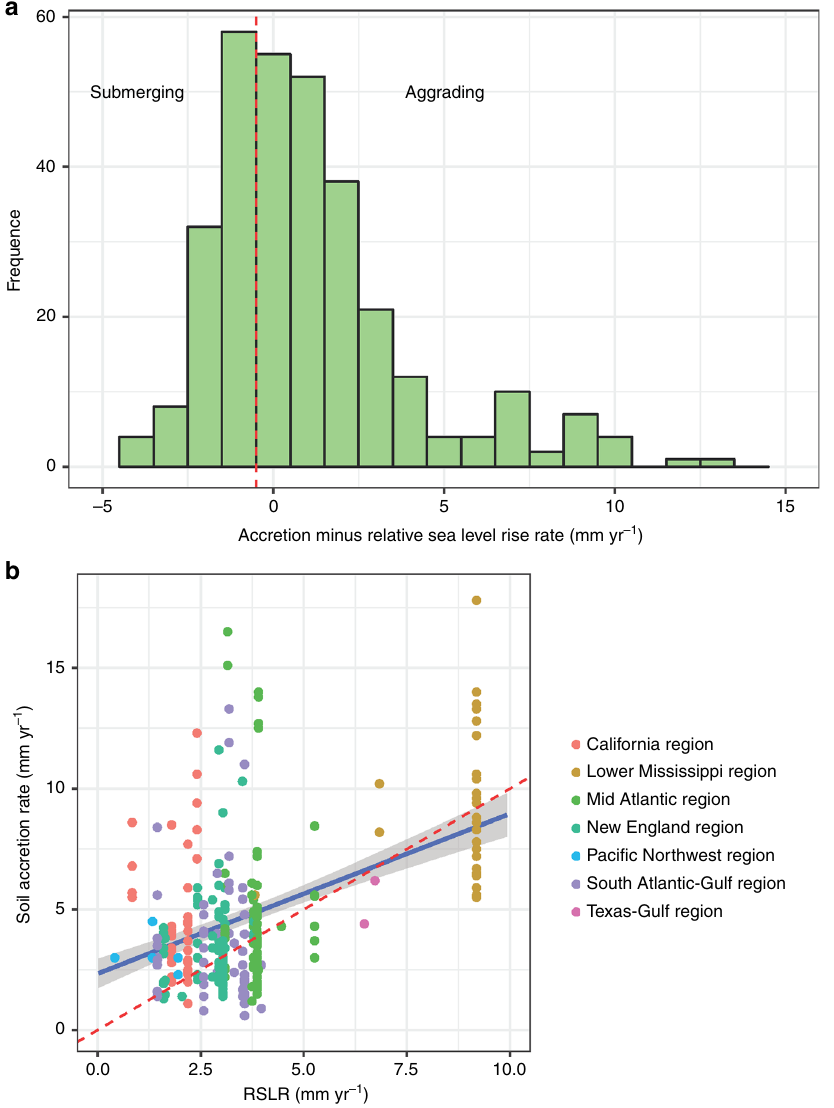
Fig. 3 Analysis of soil accretion rate and relative sea level rise rate (RSLR) in tidal wetlands of the conterminous United States. a Frequency distribution of soil accretion rate relative to RSLR, where negative rates indicate submerging wetlands and positive rates represent aggrading wetlands. b Comparison between RSLR and soil accretion rate (SAR) in different regions of CONUS. The red dashed line represents an equilibrium condition where wetlands area building vertically at the same rate that RSLR. The blue line indicates the linear relationship between SAR and RSLR with the shadow as 95% con fi dence